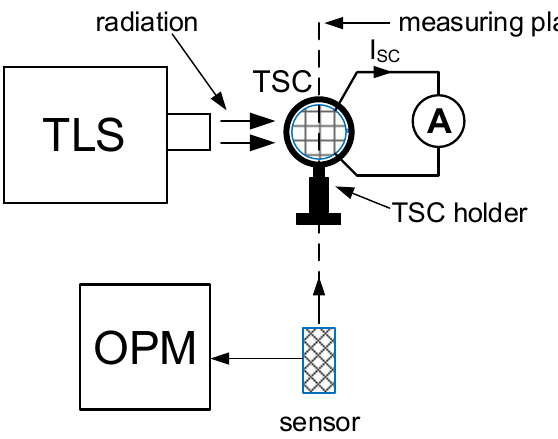
Figure 1. The setup to measure a spectral response of the tested solar